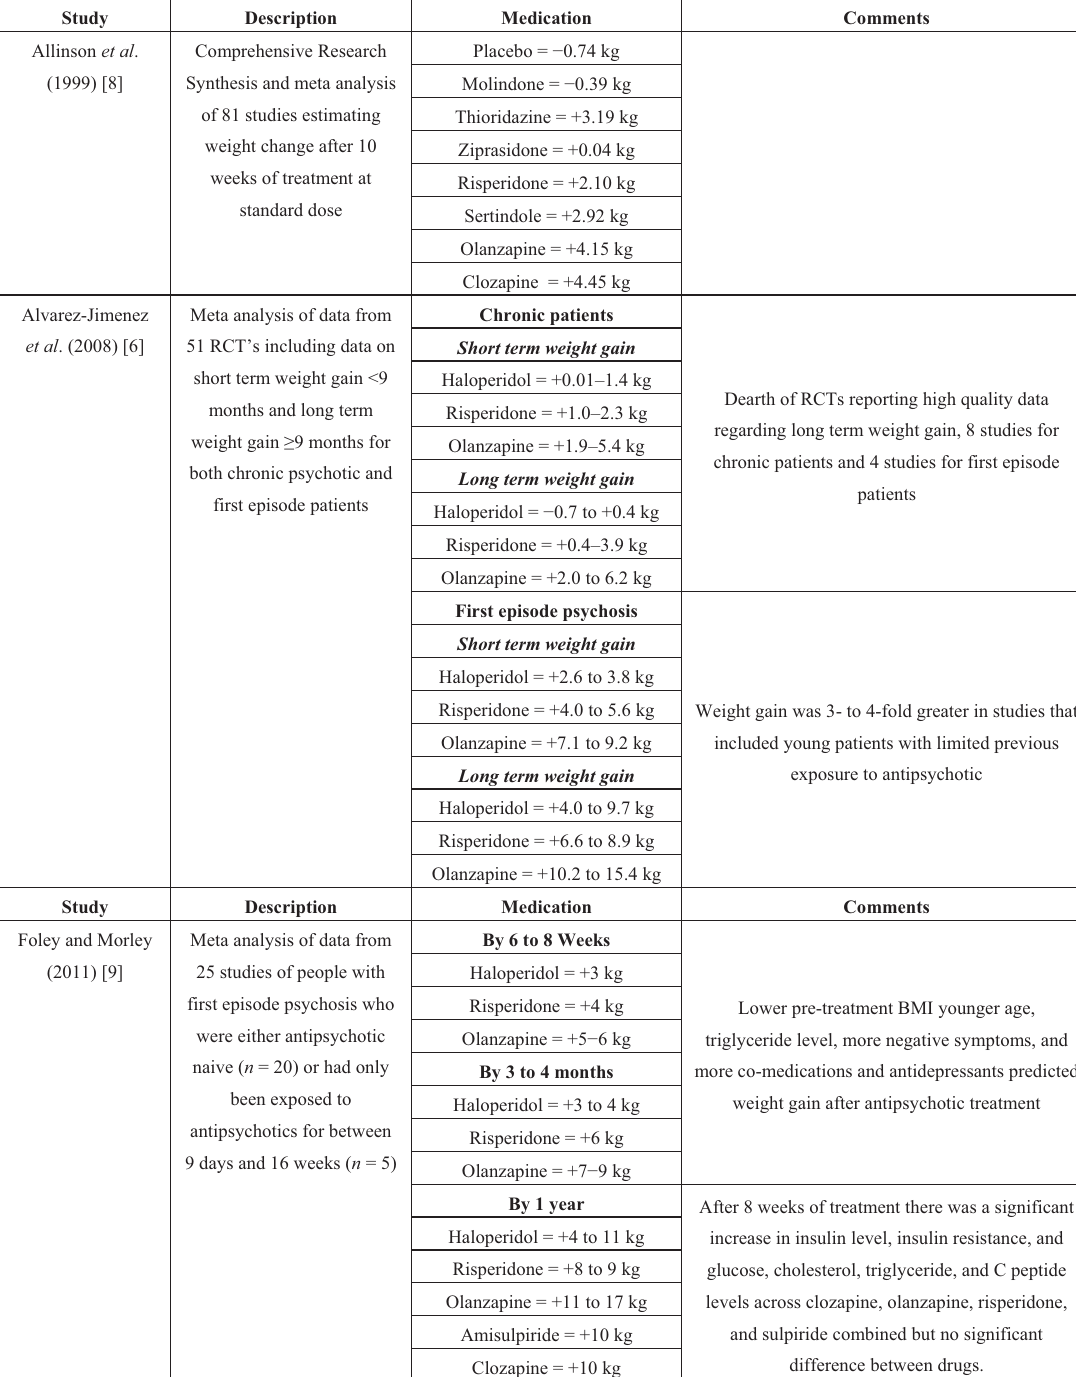
Table 3. weight gain associated with both first and second generation antipsychotic